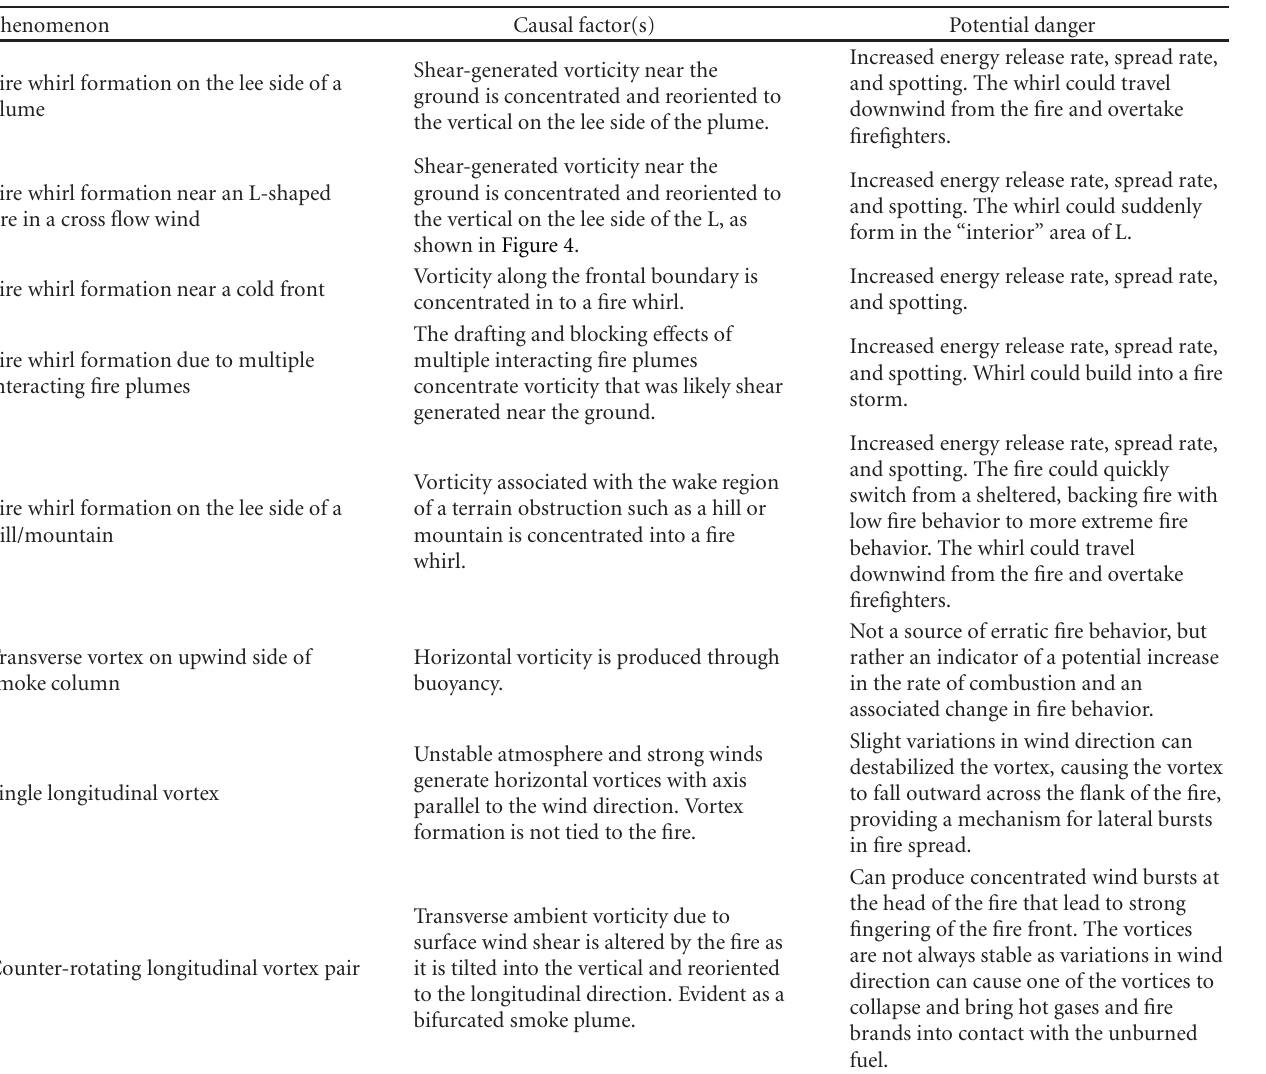
Table 1: Common vorticity forms associated with wildland fires and their